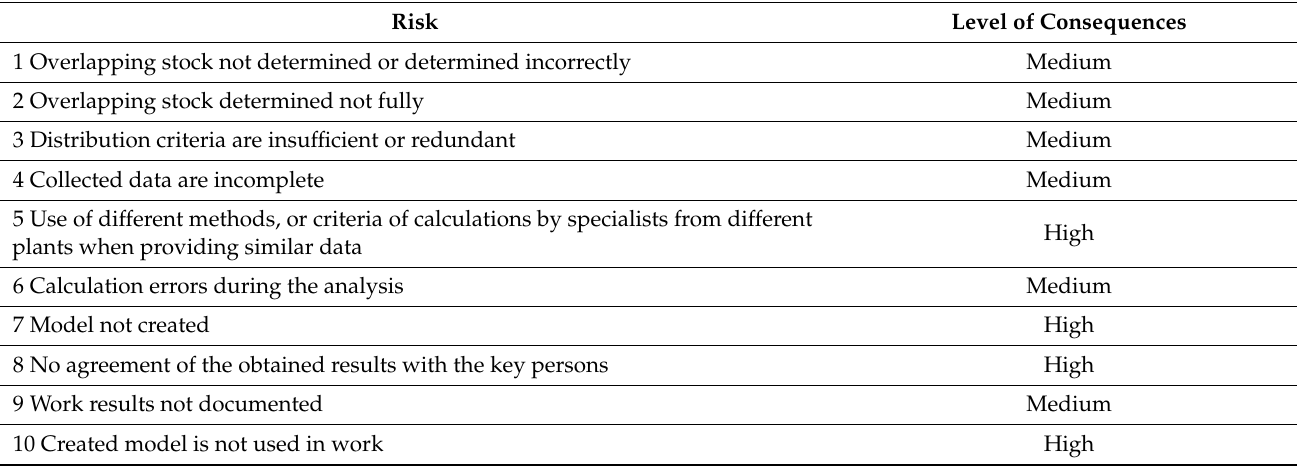
Table 5. Qualitative assessment of risk